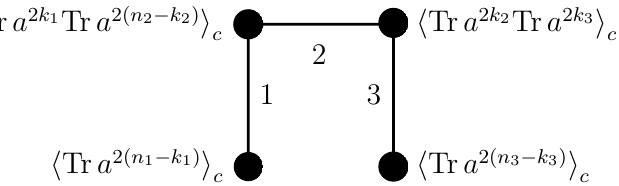
Figure 1 . How to map a product of connected correlators to a tree with labeled edges: for each connected correlator, introduce a vertex. If two vertices contain operators in the same double trace, join them by an edge. The edges are labeled by the double trace that the respective vertices have in common.